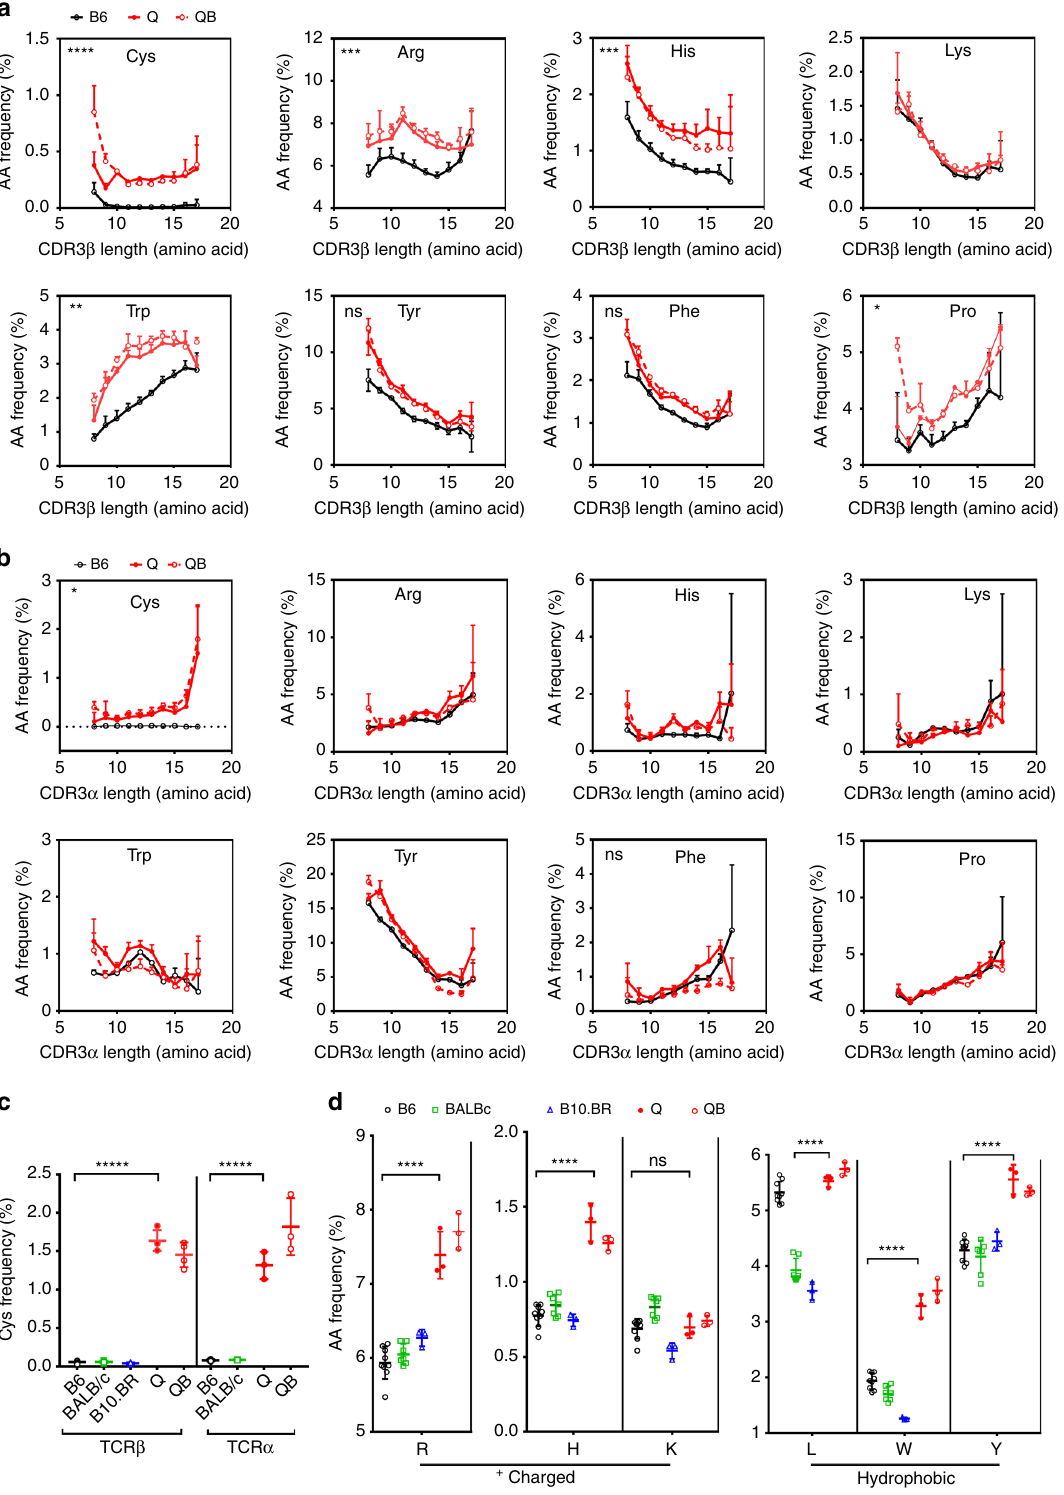
Fig. 2 CDR3 length dependent amino acid usage. a , b The frequencies of amino acids in FG-loops of CDR3 β ( a ) and CDR3 α ( b ) in B6, Q and QB repertoires with respect to their CDR3 length. c Cys usage of CDR3 β (left panel) and CDR3 α (right panel) is signi fi cantly lower in MHCr repertoires than MHCi repertoires. Our analysis excludes a germline-encoded CDR3 cysteine present in several mouse V β gene families because that cysteine is not in the FG β -loop and does not contact peptide-MHC. d Usage of charged and hydrophobic amino acid usages of MHCr repertoires and MHCi